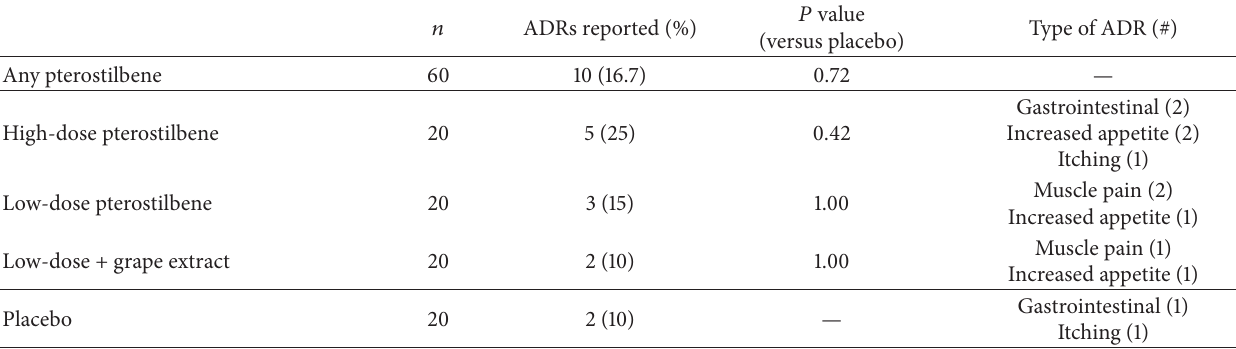
Table 2: Self-reported adverse drug reactions (ADRs) a